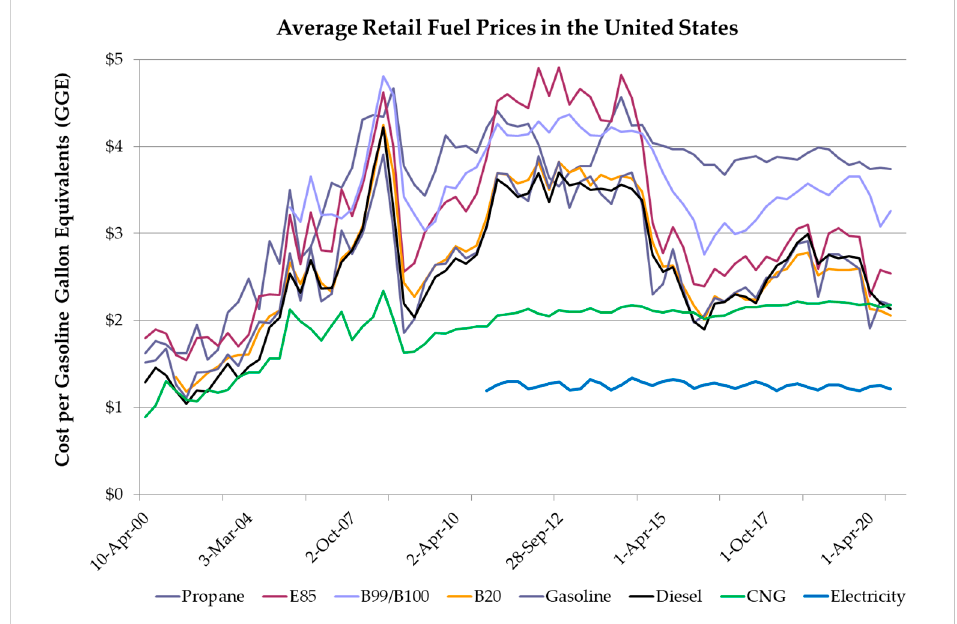
Figure 1. Average retail fuel prices in the US. Source: Clean cities alternative fuel price reports, U.S. Department of Energy [97]. Electricity data from U.S. Energy Information Administration [98].